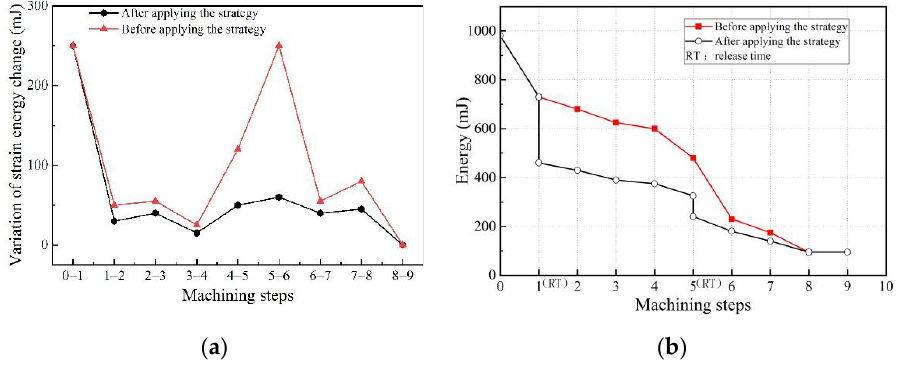
Figure 7. Effect of clamping control strategy on strain energy: ( a ) comparison of the variation of strain energy before and after applying clamping control strategy; ( b ) comparison of strain energy evolution process before and after applying clamping control strategy.